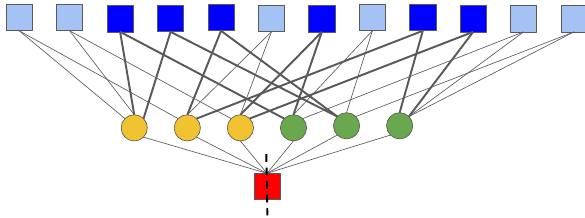
FIG. 29. Neighborhood of a Z stabilizer check in the Tanner graph of a CSS quantum code. Circles represent qubits, blue boxes in the top row represent X checks which are in the neighborhood of a Z check (red box at the bottom). Bold lines represent a cut set which induces a partition of the qubits into two sets (yellow and green) and cut on the Z check. X checks in dark blue belong to the set I and are